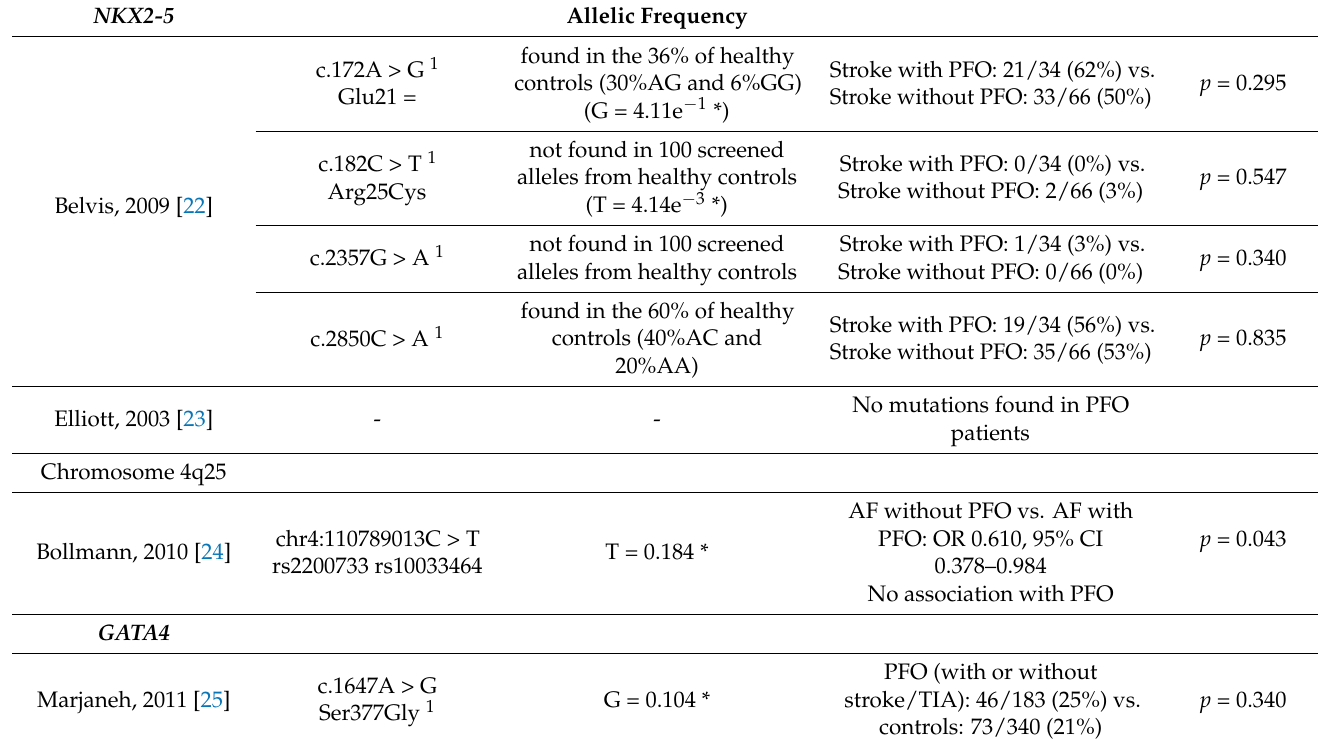
Table 2. Results of the included